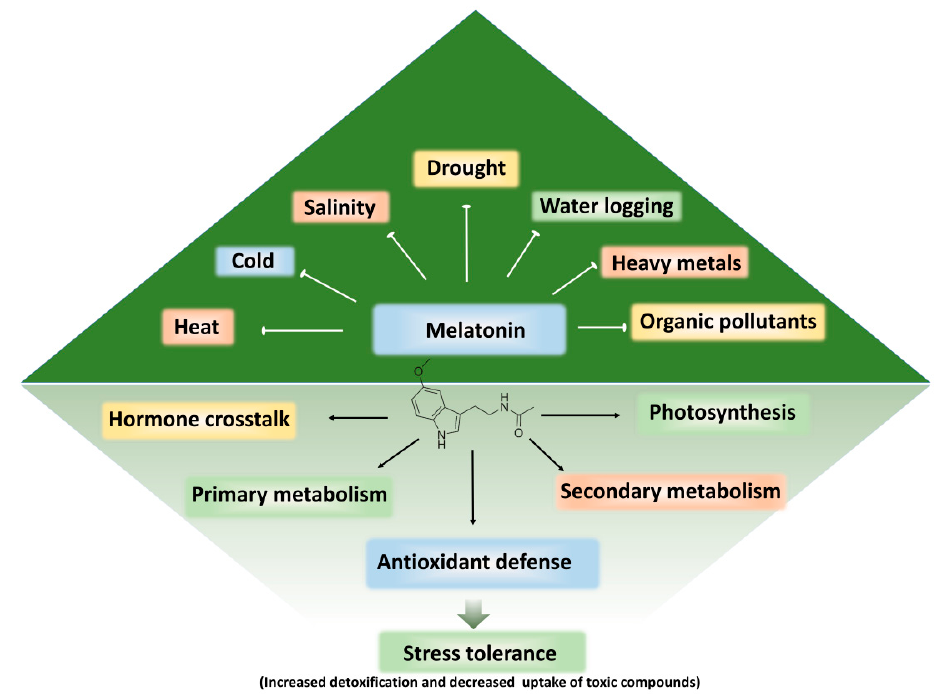
Figure 4. Melatonin effects on plant physiology, metabolism, and abiotic stress tolerance.